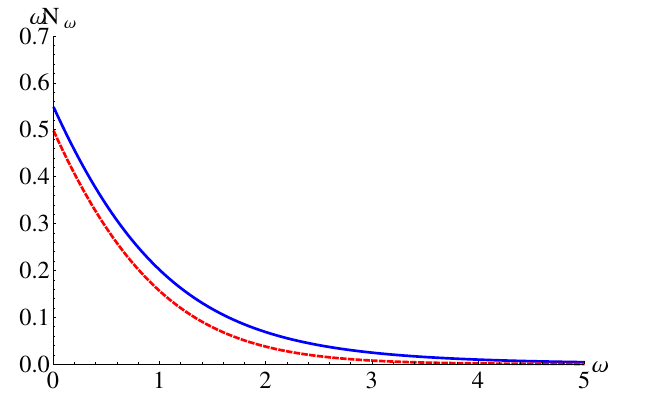
of the Unruh radiation, computed (cid:12)